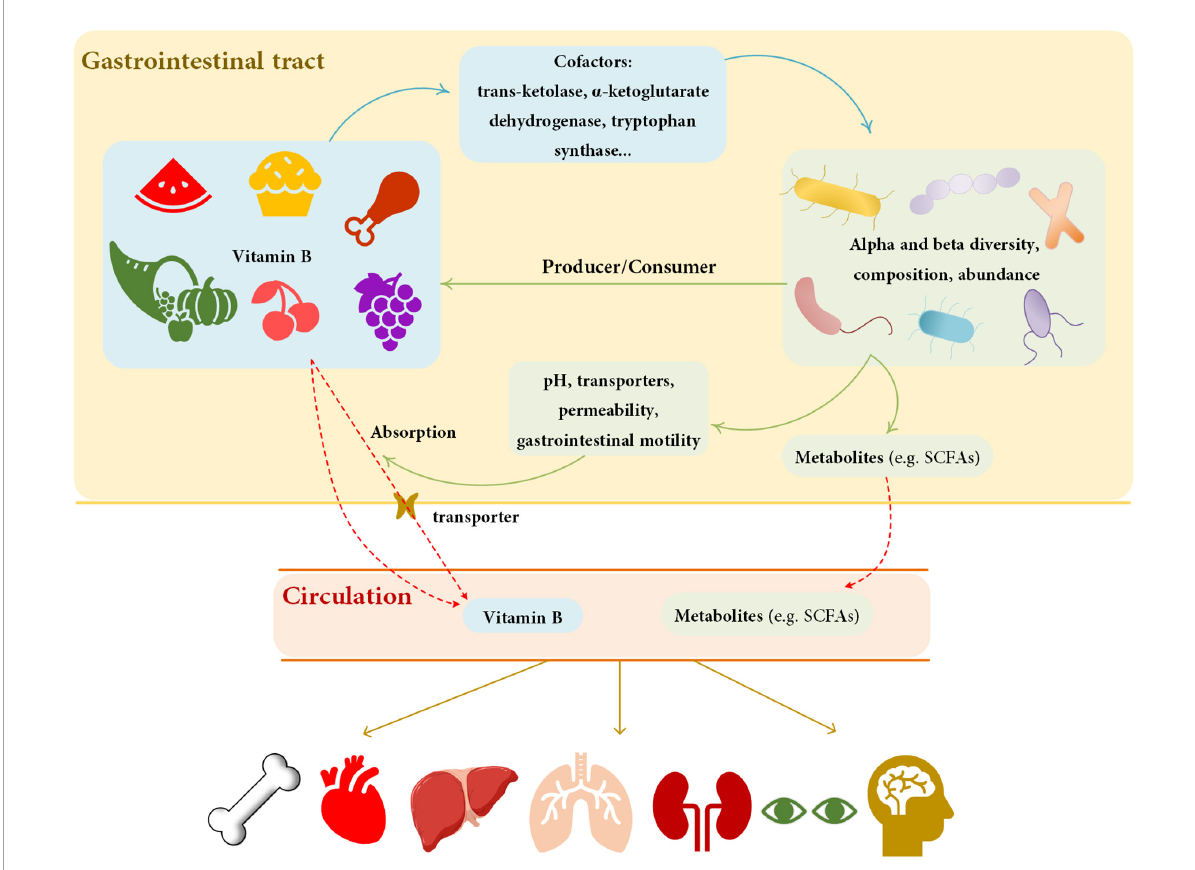
FIGURE2 Summary of the relationship between vitamin B and gut microbiota. Vitamin B can affect the diversity, composition, and abundance of gut microbiota by influencing cofactors. Gut microbiota affects vitamin B by producing or consuming and by modifying the physiological properties of the gastrointestinal tract. Solid lines represent effect, dashed lines represent transportation. The blue lines show the effect of vitamin B on gut microbiota, and the green lines show the effect of vitamin B on gut microbiota. Red lines represent the process of substance transfers into circulation. Yellow lines represent the effects of circulation substances on organs. The metabolites of gut microbiota and dietary vitamin B can affect human health. SCFAs, short chain fatty